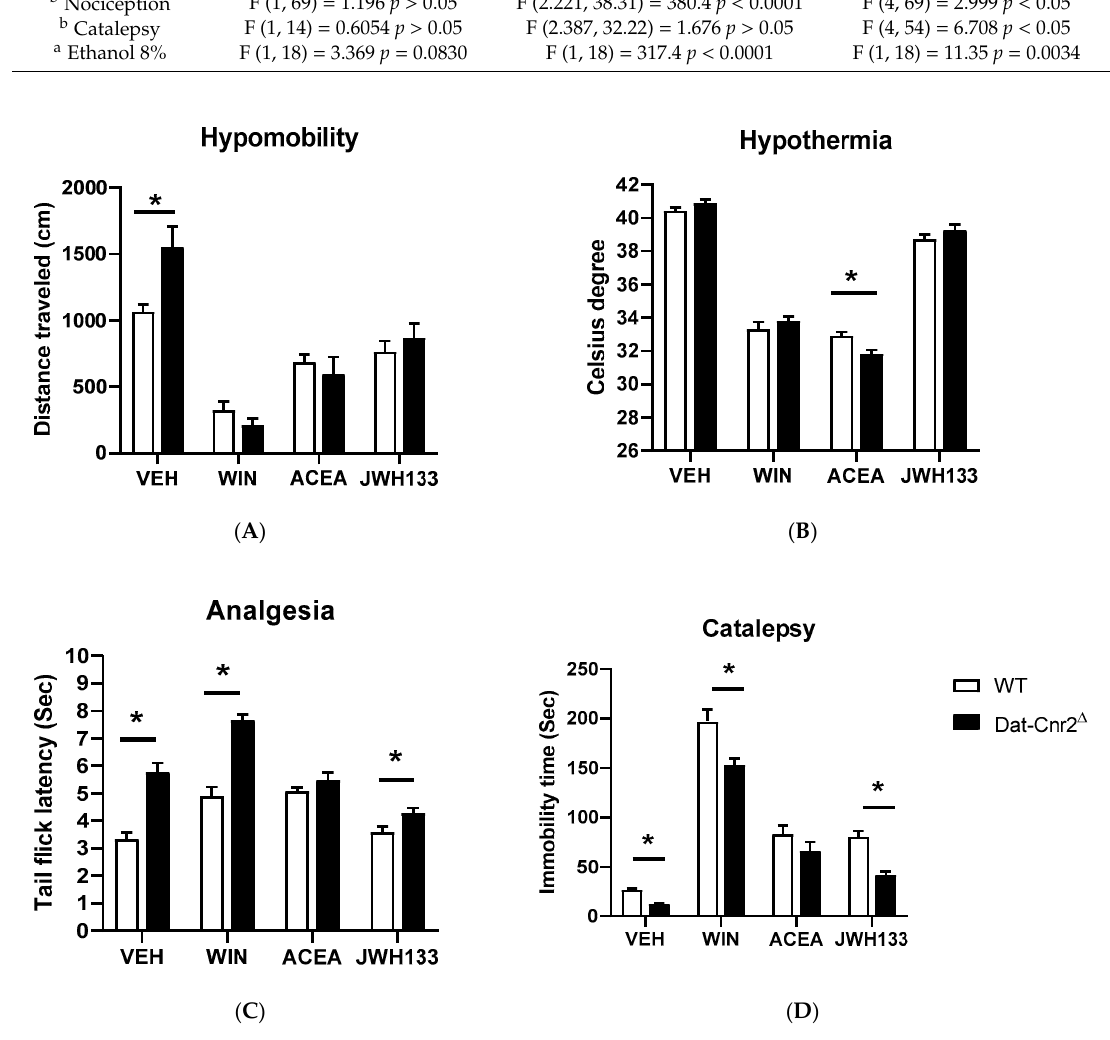
Figure 5. CB2R-mediated behaviors in the tetrad effects in DAT-Cnr2 Δ mice. The effects of CB1R, CB2R and mixed CB1R and CB2R ligand, WIN 55212-2 (3.0 mg/kg), ACEA (1.0 mg/kg) and JWH133 (20 mg/kg) in the tetrad effects. ( A ) Hypomobility; ( B ) hypothermia; ( C ) analgesia (tail-flick nociception test and a similar result in the hot plate test); ( D ) catalepsy. Asterisks represent p < 0.05.